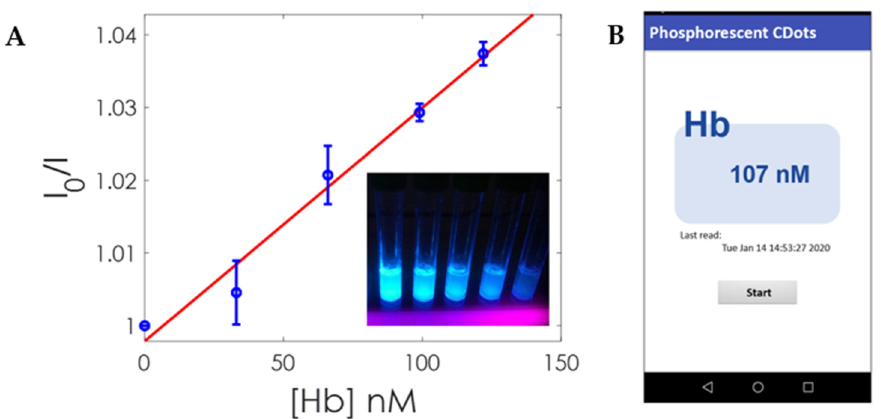
Figure 9. ( A ) Intensity based ( I 0 / I ) Stern–Volmer plot for different concentrations of Hb. Inset shows a UV-illuminated photograph of CDs with different concentrations of Hb. ( B ) App screenshot showing the result of one measurement.